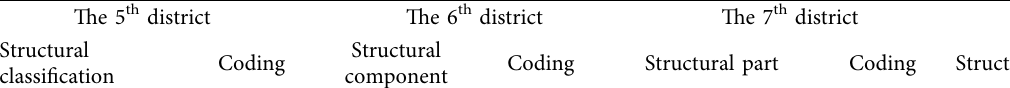
Table 5: Bridge EBS coding (from the 5 th –8 th